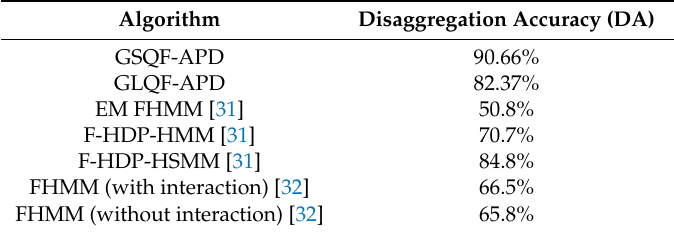
Table 5. Disaggregation accuracy comparison with [31] and [32] for House